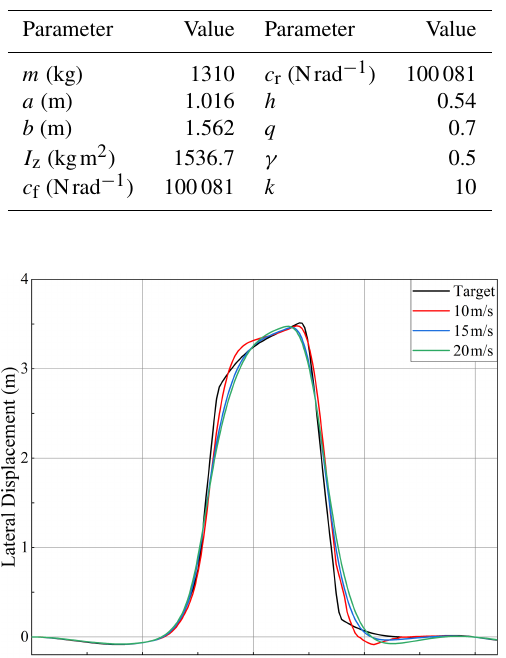
Table 2. Vehicle model parameters and controller parameters.